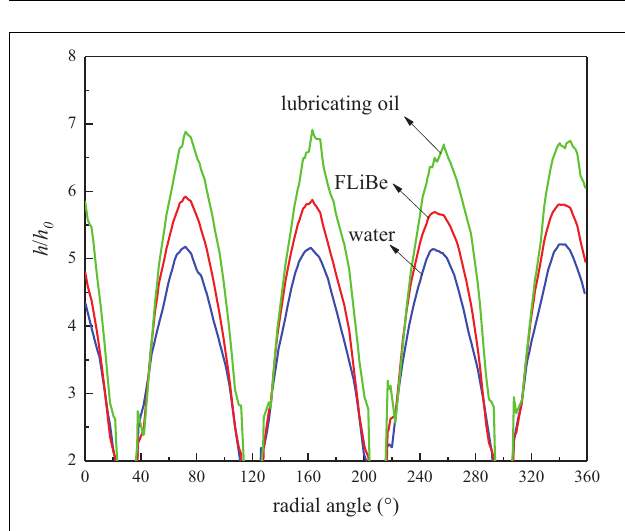
FIGURE 10 | Local heat transfer coefficient ratio of various working fluids in the tube fitted with CCDTT ( y = 3) at l = 0.24 m, Re = 720.